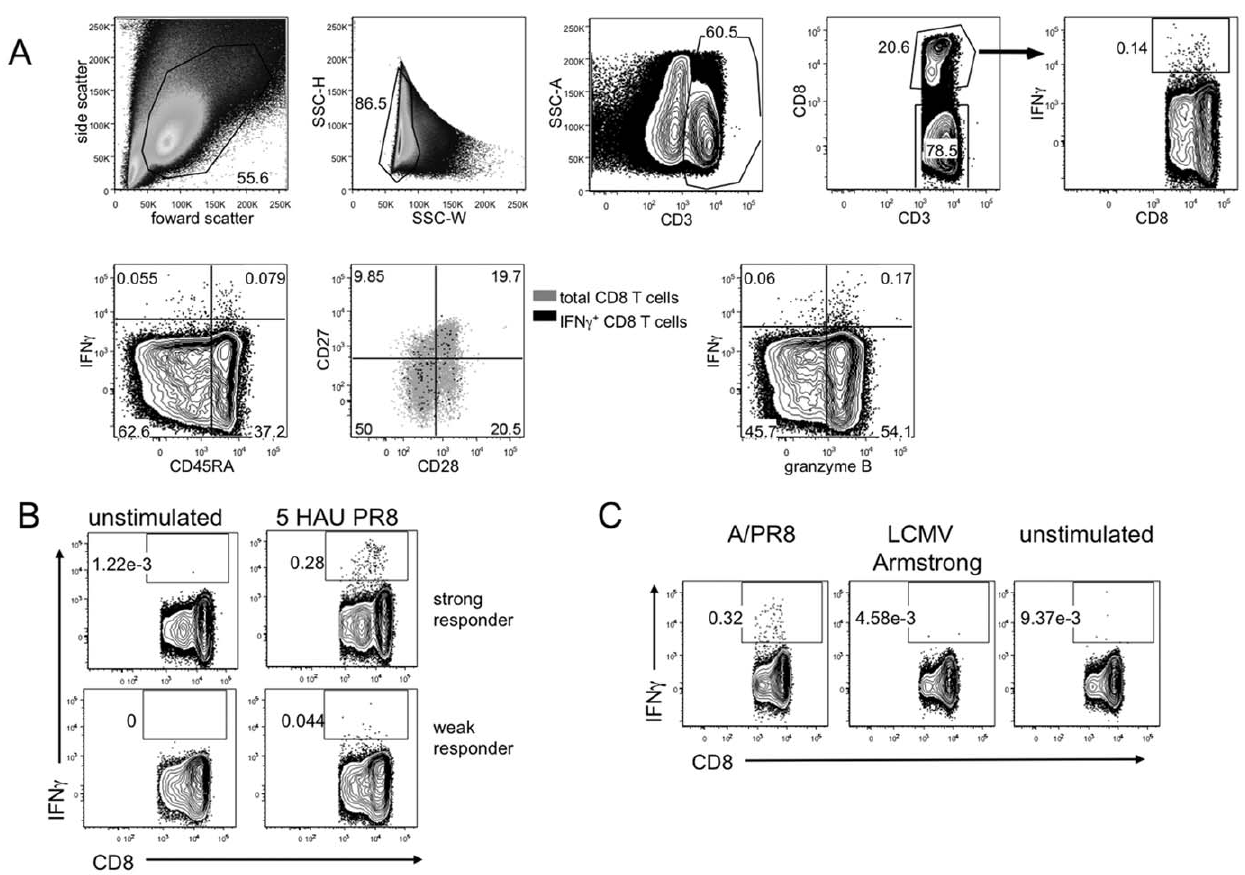
Figure 1. Flow cytometry gating strategy and specificity controls for detection of CD8 + and CD8 2 T cells producing IFN c in response to live influenza virus challenge. Total PBMC from under 40 years old donors and 65 + donors were stimulated with influenza A/PR8 for 18h as described in the methods, then stained for intracellular IFN c and analyzed by flow cytometry. Influenza-responsive T cells were considered to be those that produced IFN c after 18 hours of stimulation. Gates were drawn based on FMO controls. (A) Representative gating of flow cytometry data collected from total PBMC of an older donor stimulated with PR8. (B) CD8 T cells from two donors representing strong ( top panels ) and weak ( bottom panels ) IFN c responses to PR8 stimulation. (C) CD8 T cell IFN c responses to influenza virus stimulation ( left ), an irrelevant control virus, lymphocytic choriomeningitis virus Armstrong strain ( middle ) or without stimulation ( right ) for 18 hours.